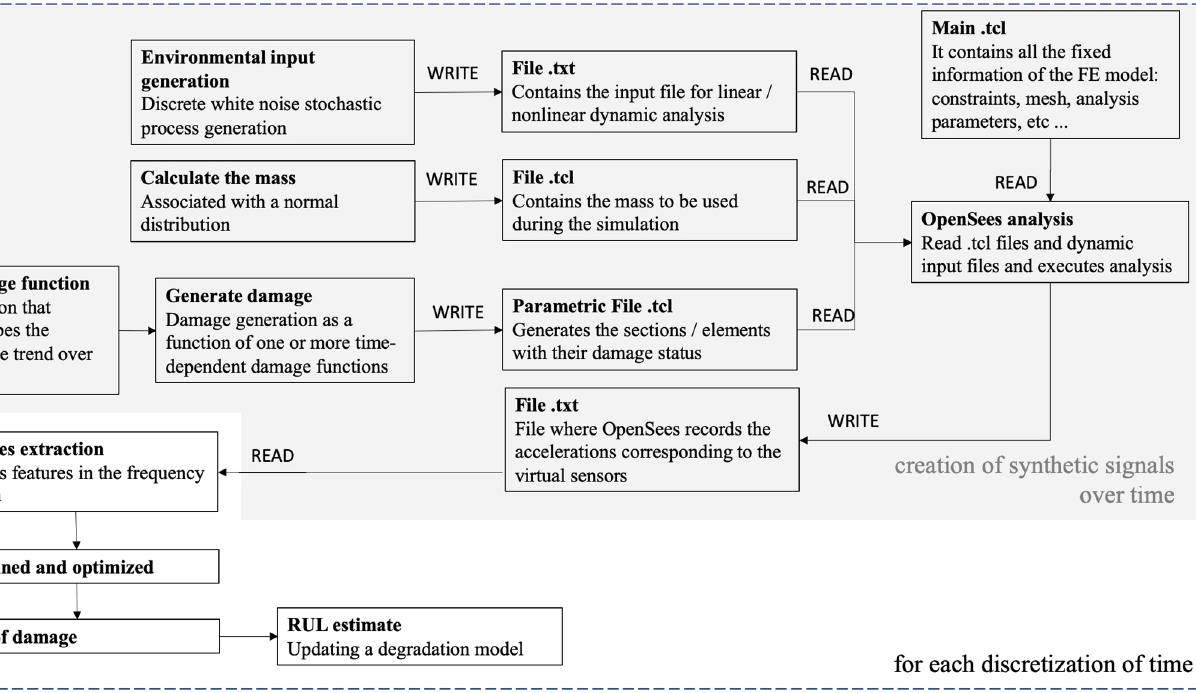
Figure 15. Framework for estimating RUL.